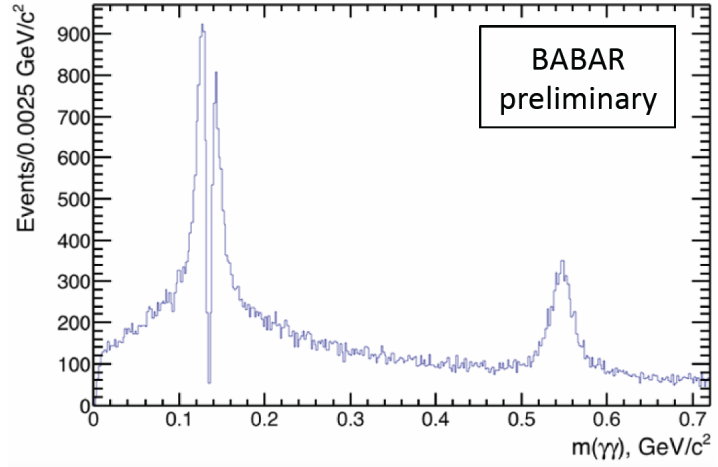
Figure 7. Invariant mass of the third photon pair in the selected e + e − → π + π − π 0 π 0 γγ events.